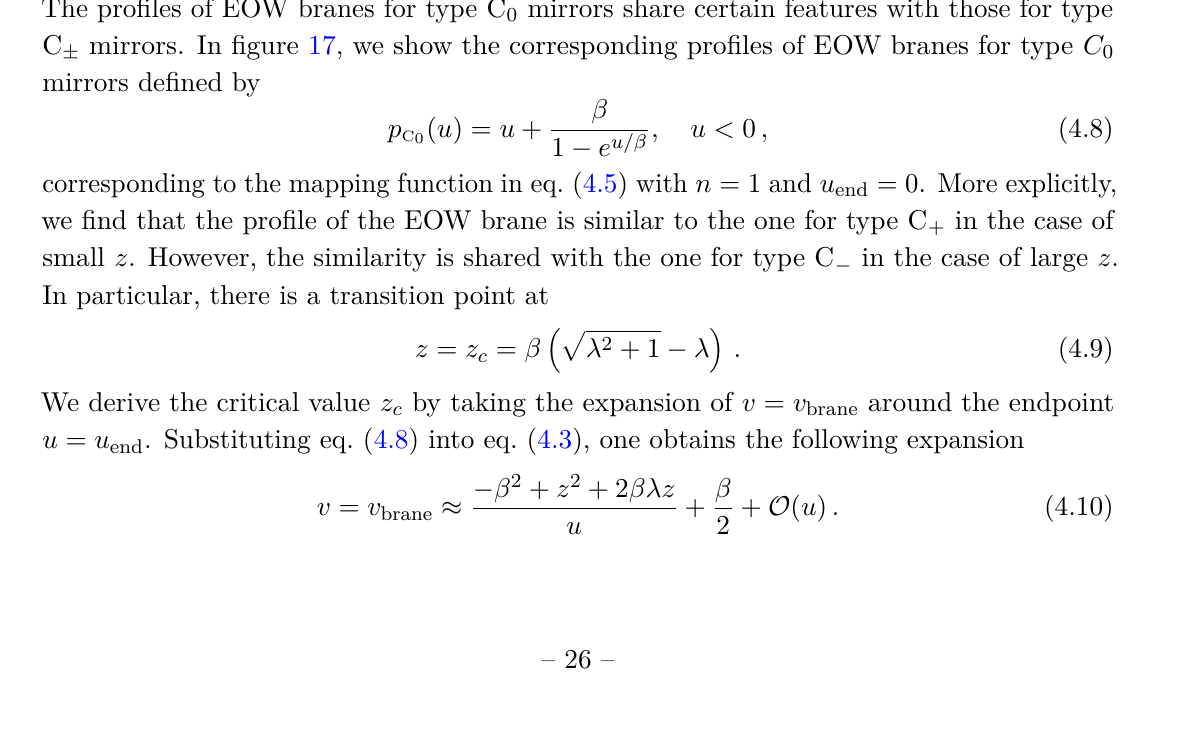
= 0 , and n = 1 / 2 for both end